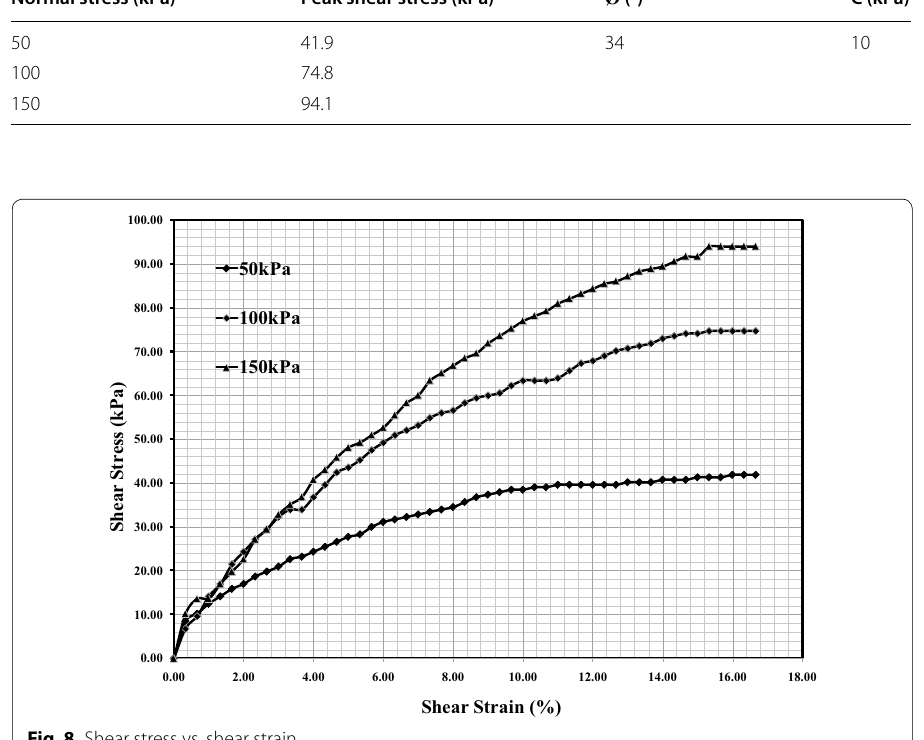
Fig. 8 Shear stress vs. shear